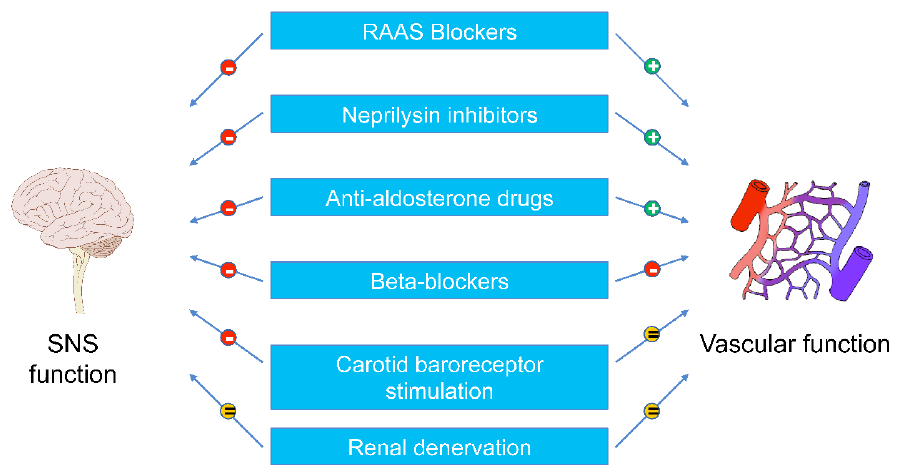
Figure 2. Effects of various therapeutic procedures on sympathetic and vascular dysfunctions in CHF. Symbol “+” means positive effects, and symbol “ − ” negative effects. RAAS, renin–angiotensin– aldosterone system. Other abbreviations as in Figure 1.